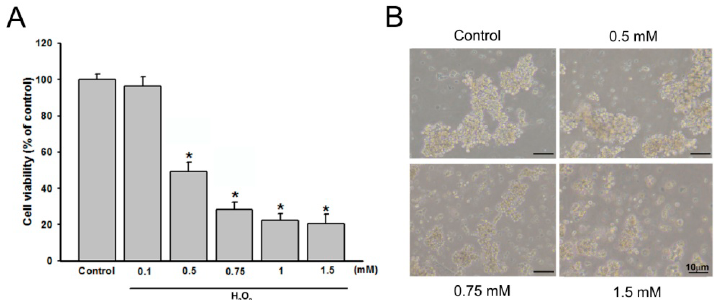
Figure 2. Effects of H 2 O 2 on PC12 cell viability and cell morphology. ( A ) Effect of H 2 O 2 on viability of PC12 cells (exposure to 4 h). A MTT assay showed that H 2 O 2 decreased cell viability in a concentration-dependent manner; ( B ) treatments with different concentrations induced cell morphological alterations. Data were summarized from three independent experiments. * p < 0.05 vs . control group.